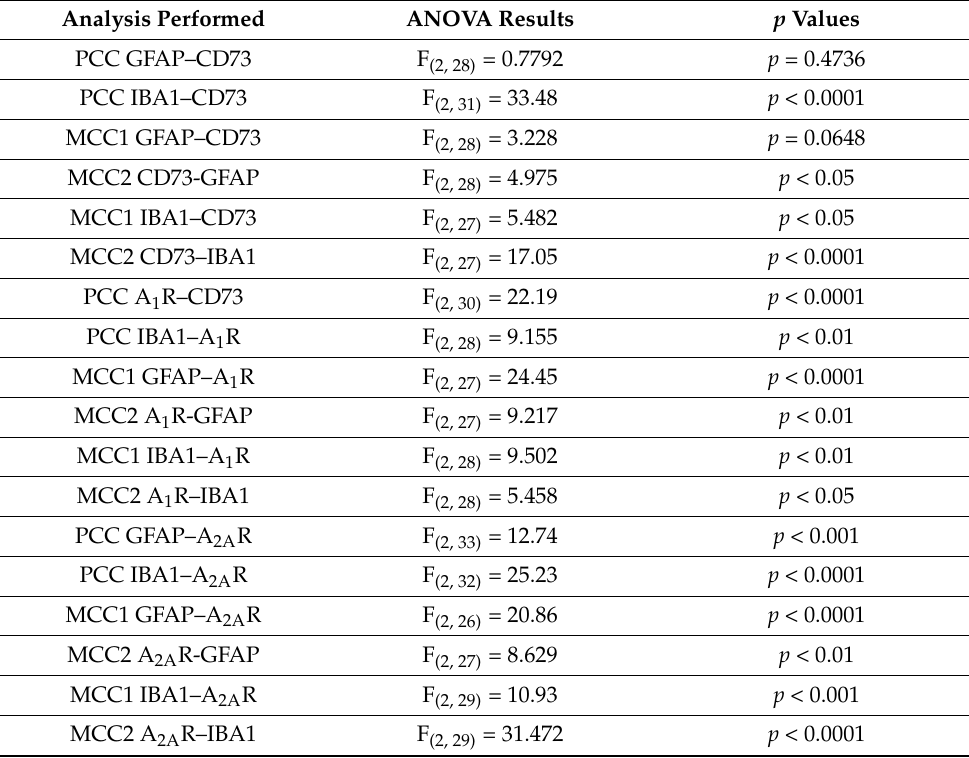
Table 2. Results of ANOVA analysis performed for results obtained from image